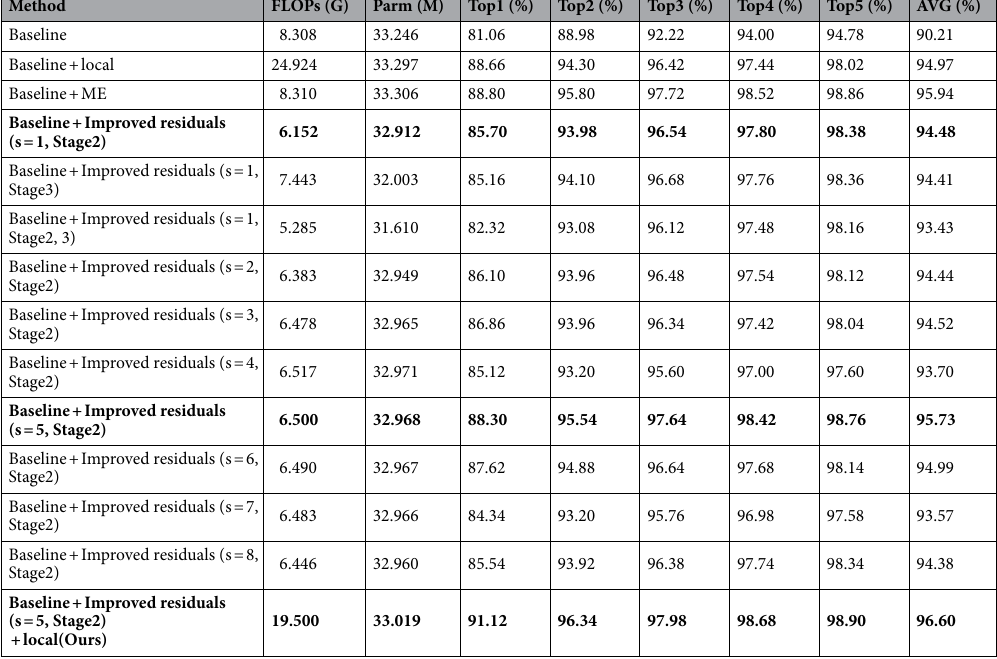
Table 6. Experimental results of improved residual module and fused hand region ablation. Significant values are in bold.